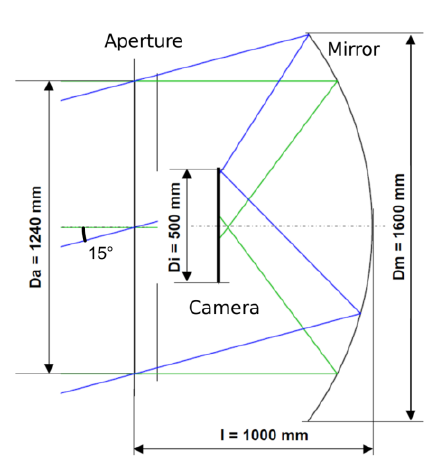
Fig. 2. The dimensions of the FAST prototype optical system. D a is the face-to- face size of the octagonal telescope aperture, D i is the side length of the square camera box, D m is the diameter of the primary mirror, and l is the mirror-aperture distance.